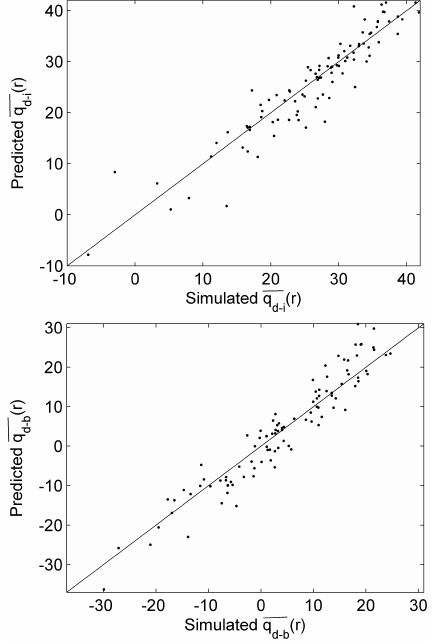
Fig. 4. Regression estimates of 1q ( r ) versus the corresponding simulated